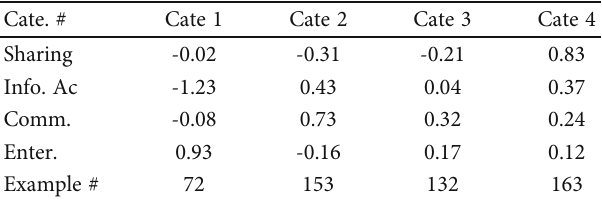
Table 1: Cluster center and the number of